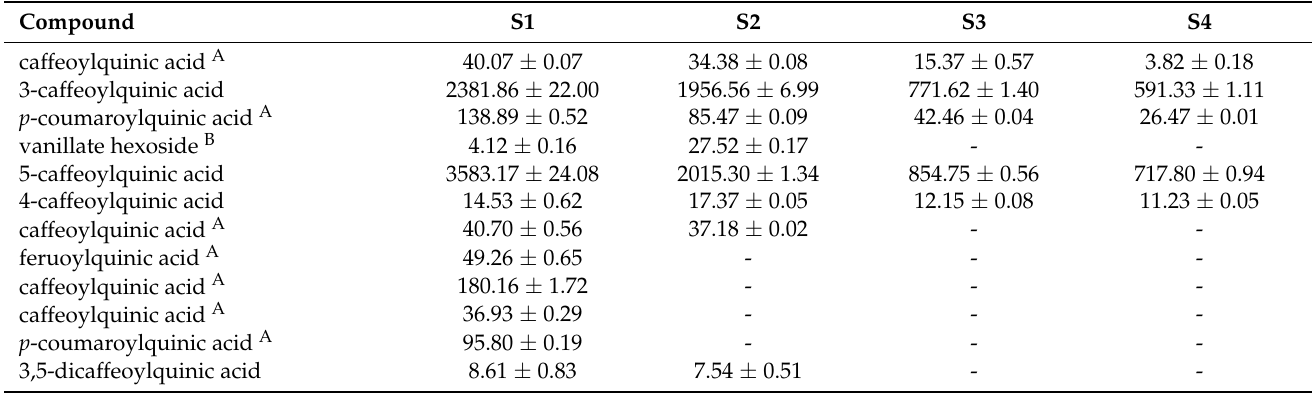
Table 3. Content (mg/100 g DW) of phenolic compounds in black chokeberry fruit during